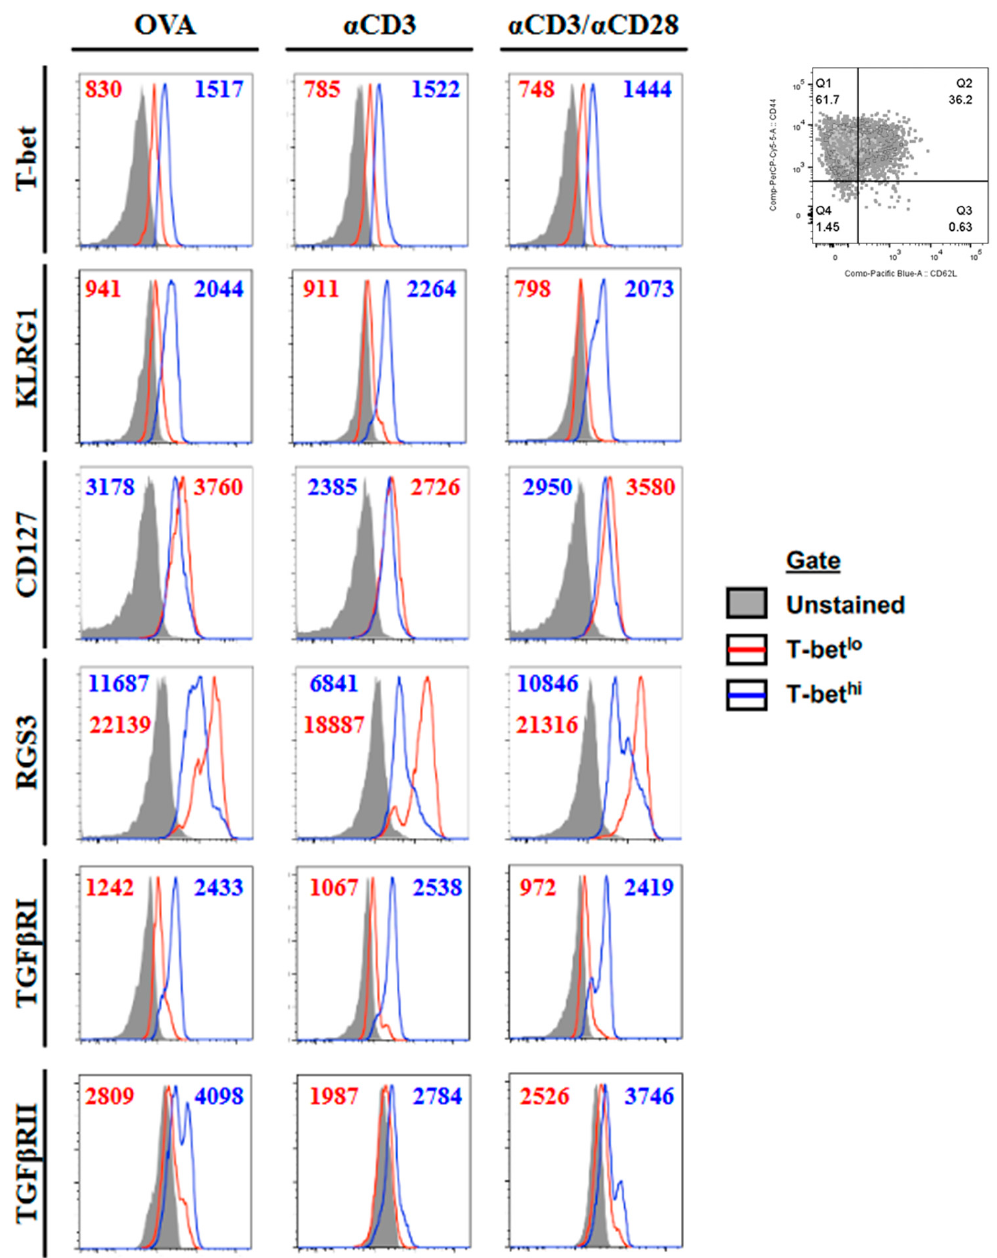
Figure 1. Phenotype of T-bet hi and T-bet lo effector CD8 T cells. OT-I splenocytes were activated in vitro for 5 days with either OVA 257 , anti-CD3 ε mAb, or anti-CD3 ε and anti-CD28 mAbs. Cells were gated on CD8 CD44 hi (upper right) and T-bet hi or T-bet lo (gated from T-bet vs. CD8 plot). Histograms demonstrate the expression levels of T-bet, KLRG1, CD127, TGF β RI, TGF β RII, and RGS3 in unstained controls (gray-filled histograms) and T-bet lo (red line) and T-bet hi (blue line) CD8 effector T cells. Mean fluorescence intensities are shown for T-bet lo (red text) and T-bet hi (blue text) CD8 T cells for each plot. The data shown are representative of at least three individual experiments with similar results.